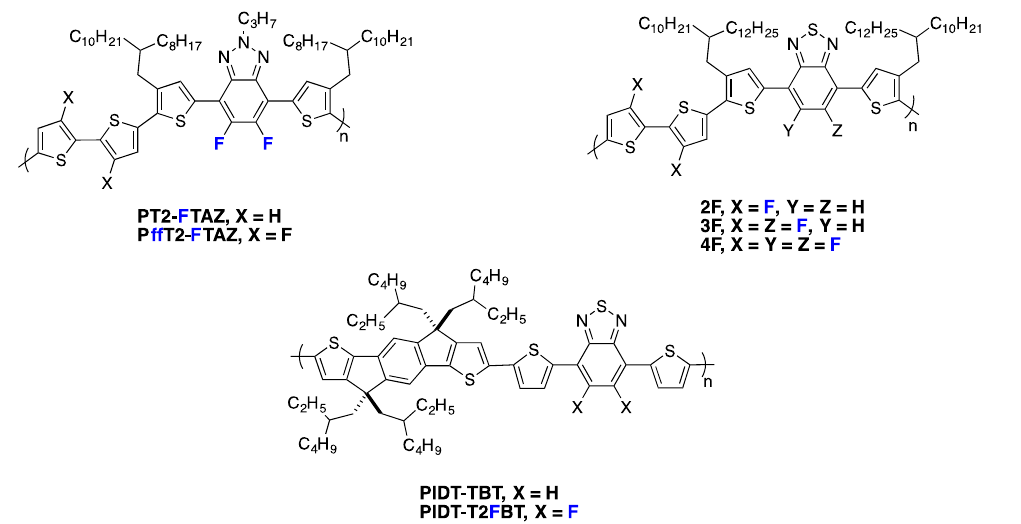
Figure 14. Chemical structures of some fluorinated polymers.